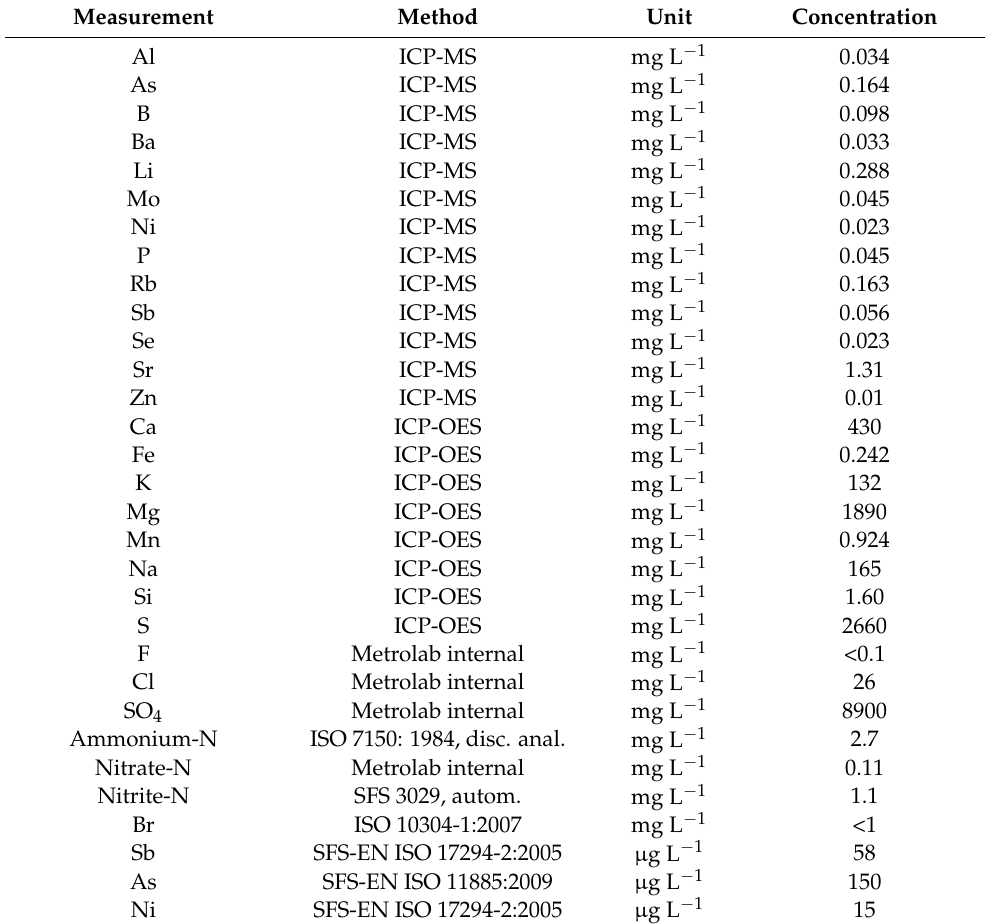
Table 1. Chemical parameters of the mine waste water. In addition, Ag, Be, Bi, Cd, Cr, Ph, Th, and Tl were present at <0.001 mg L − 1 , and Co, Cu, U, and V at <0.005 mg L − 1